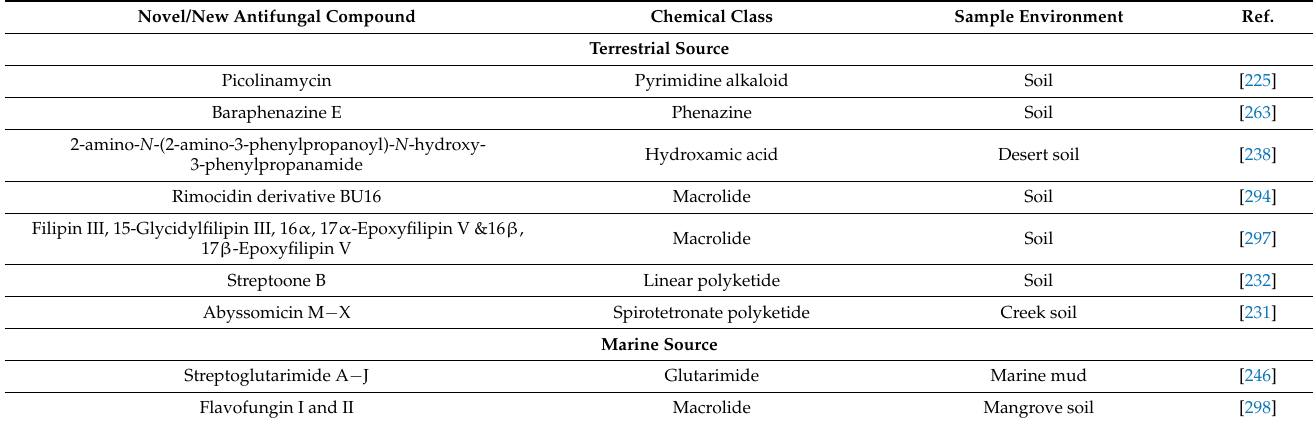
Table 12. Novel/new antifungal therapeutic compounds isolated from Streptomyces spp. between 2015 and 2020.